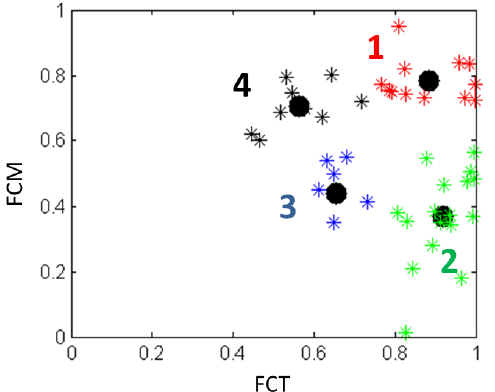
Figure 7. Fraction of positively contributing temperature (FCT; X -axis) and the fraction of positively contributing moisture (FCM; Y -axis) to VPD under extreme and exceptional drought categories (USDM D3 and D4). The Kmeans clustering method is used for classifying the fractions into four groups shown in different colors. The black dots show the centroid of each of the four